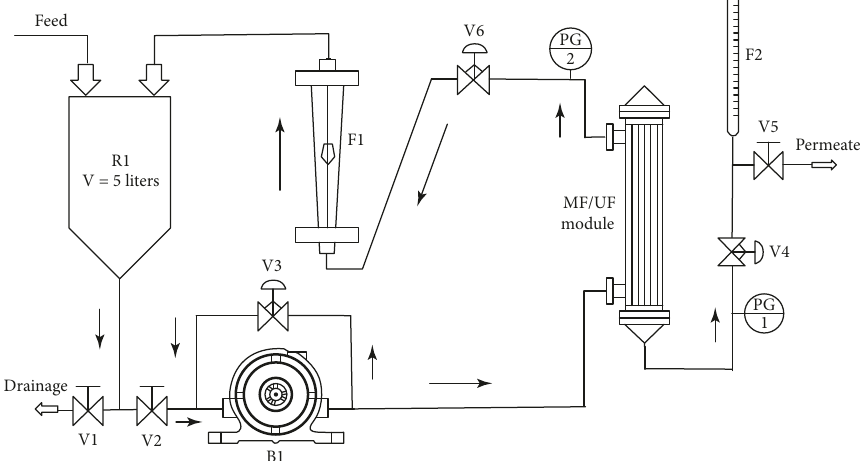
Figure 1: Schematic diagram of micro/ultrafiltration system (MF/UF, cross-flow hollow fiber membrane module; B1, pump; R1, feed tank; F1, F2, flowmeter; V6, back pressure valve; V1–V6, valves; PG1, PG2, pressure